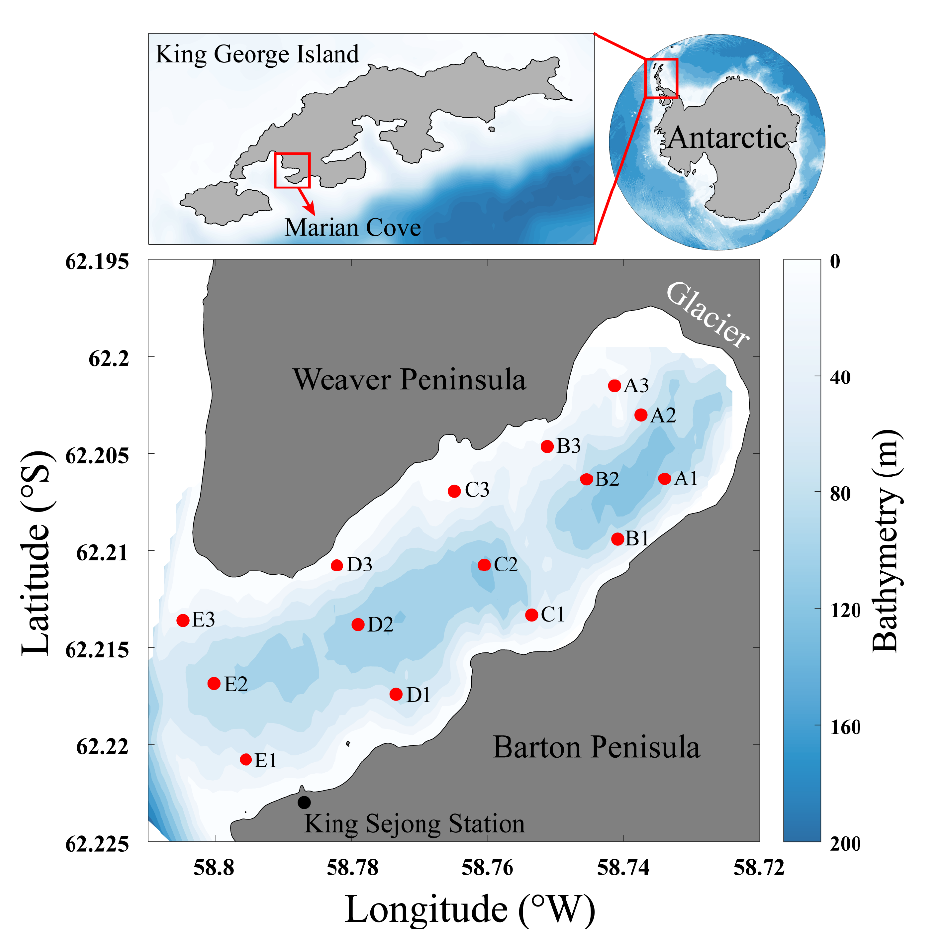
Figure 1. Map showing the sampling locations in Marian Cove, King George Island, Antarctic. The color bar indicates water depth in meters.